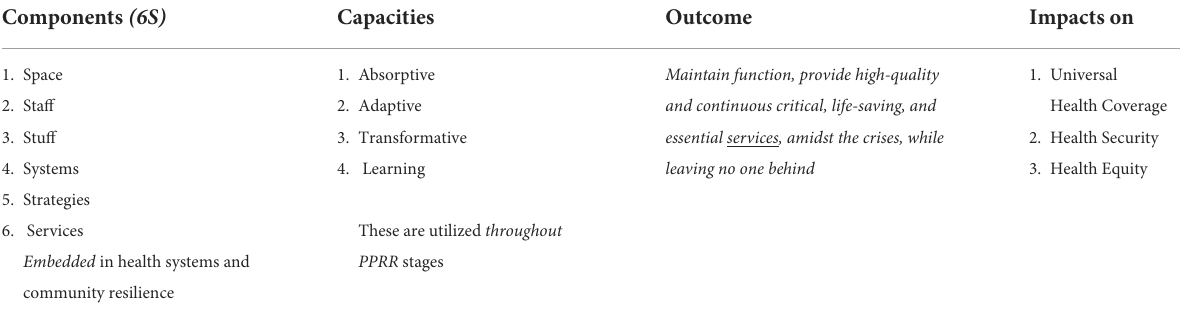
TABLE 4 Summary of proposed conceptual framework on hospital resilience. Components